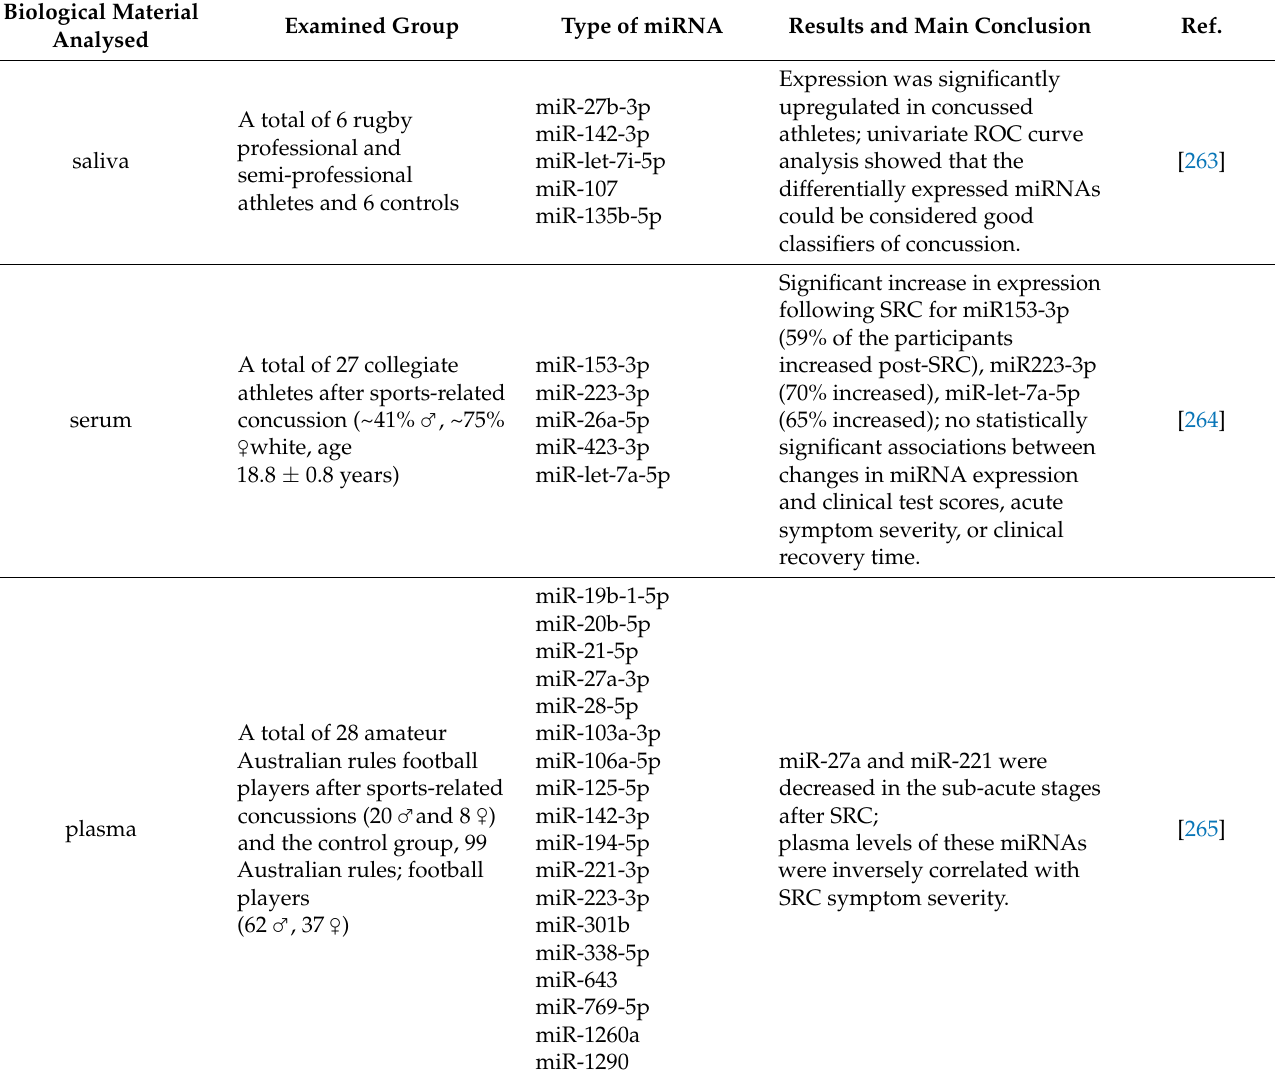
Table 5. Clinical studies of circulatory miRNAs after sports-related TBIs. Type of miRNA Results and Main Conclusion